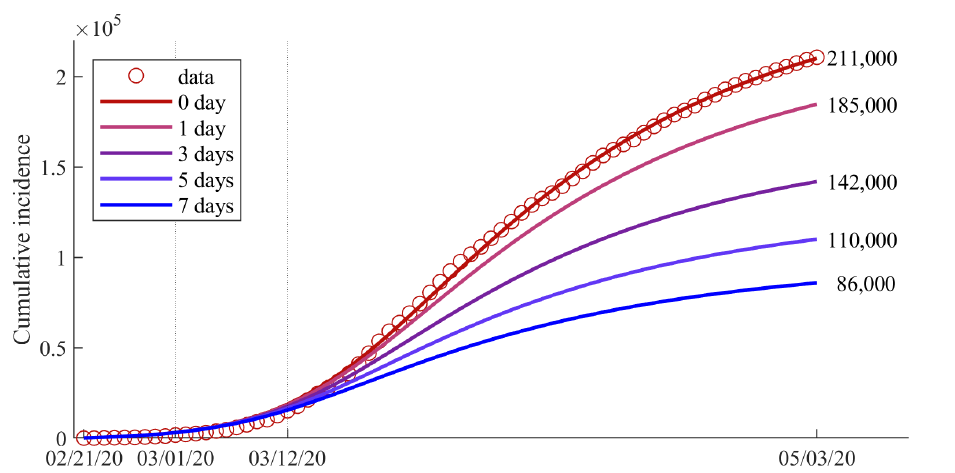
Figure 6. Expected number of cumulative confirmed cases when BCT was advanced by n d , for n = 0, 1, 3, 5, and